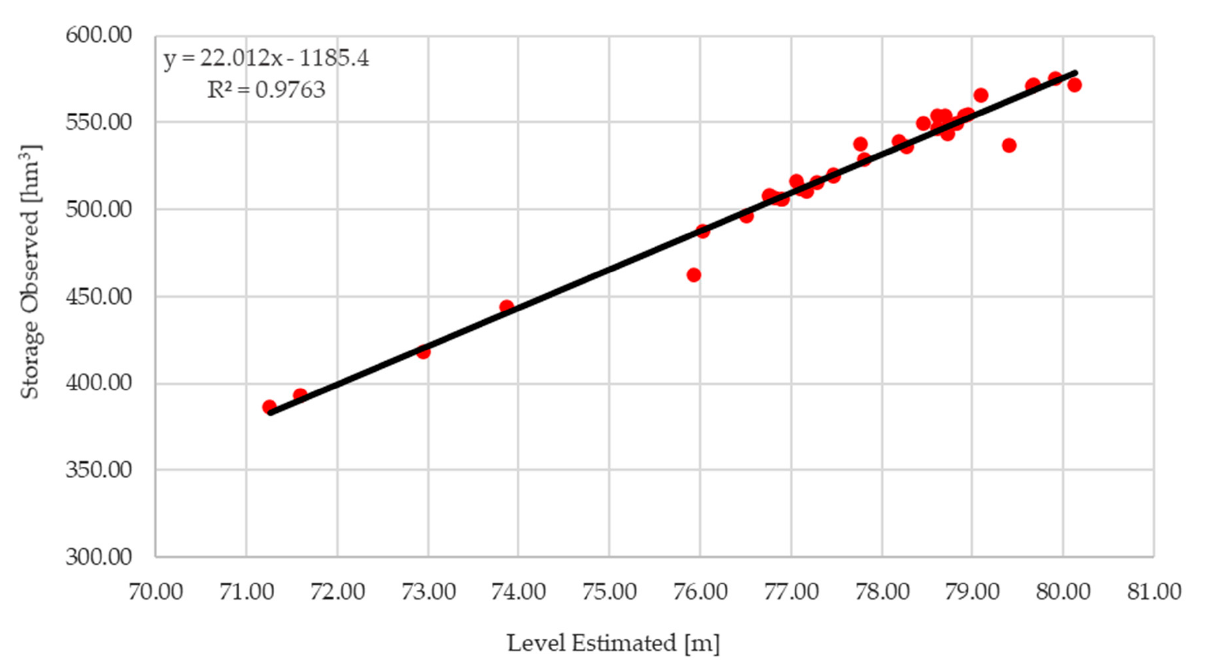
Figure 9. Scatter plot of level–storage variation pairs. 3.3. Combination of Sentinel-2 and Sentinel-3 Data Different time lags between Sentinel-2 and 3 products were examined, ranging from 1 to 10 days, while considering the reservoir’s in situ observed storage variability. The 1- day, 5-day, and 7-day variations are depicted in Figure 10 as percentages of the reservoir’s maximum storage, along with the observed storage time series for the time period covered by both Sentinel-2 and Sentinel-3 data. Regarding daily storage variation from the end of October 2018 until the end of October 2021, an average variation of 0.10% of the reservoir’s